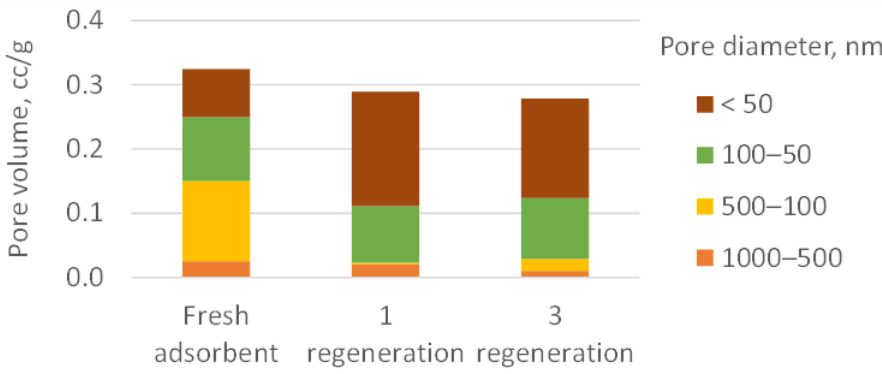
Figure 3. Adsorbent Thermogravimetric/Differential Thermal Analysis (TG/DTA).